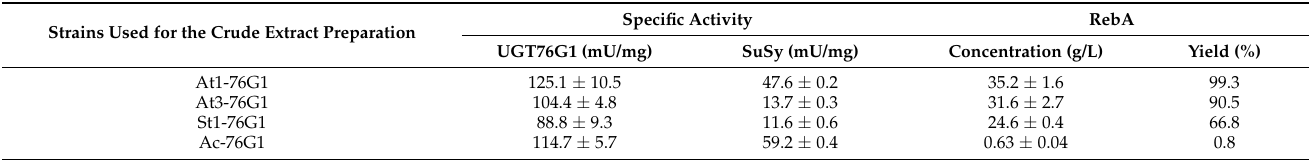
Table 3. Effect of the coupled SuSy and UGT76G1 on RebA synthesis. Specific Strains Used for the Crude Extract Preparation